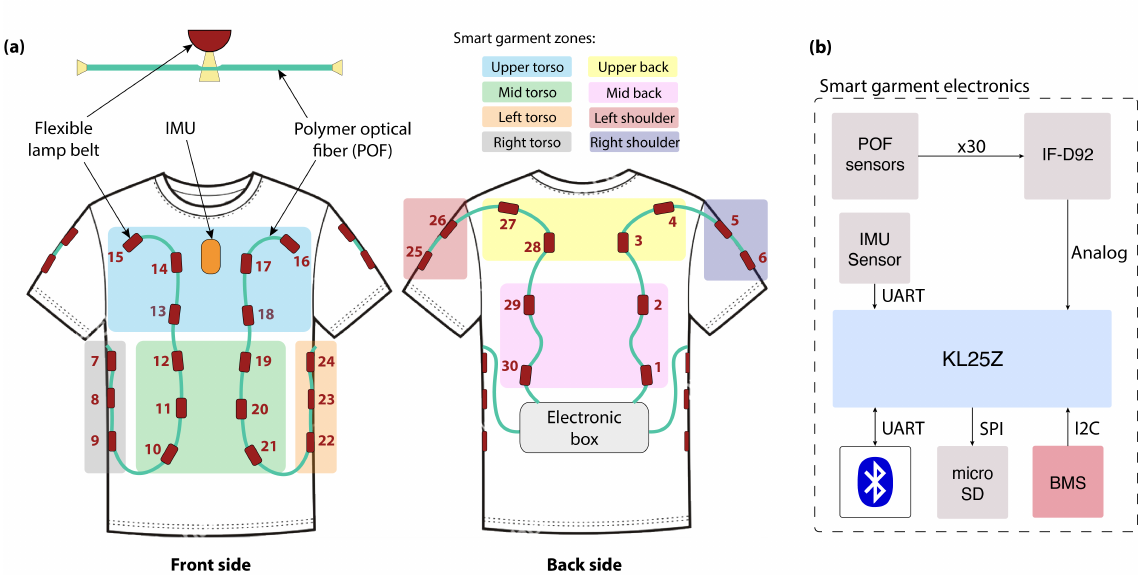
Figure 3. Smart garment overview: ( a ) Components and zones differentiation; ( b ) Electronic